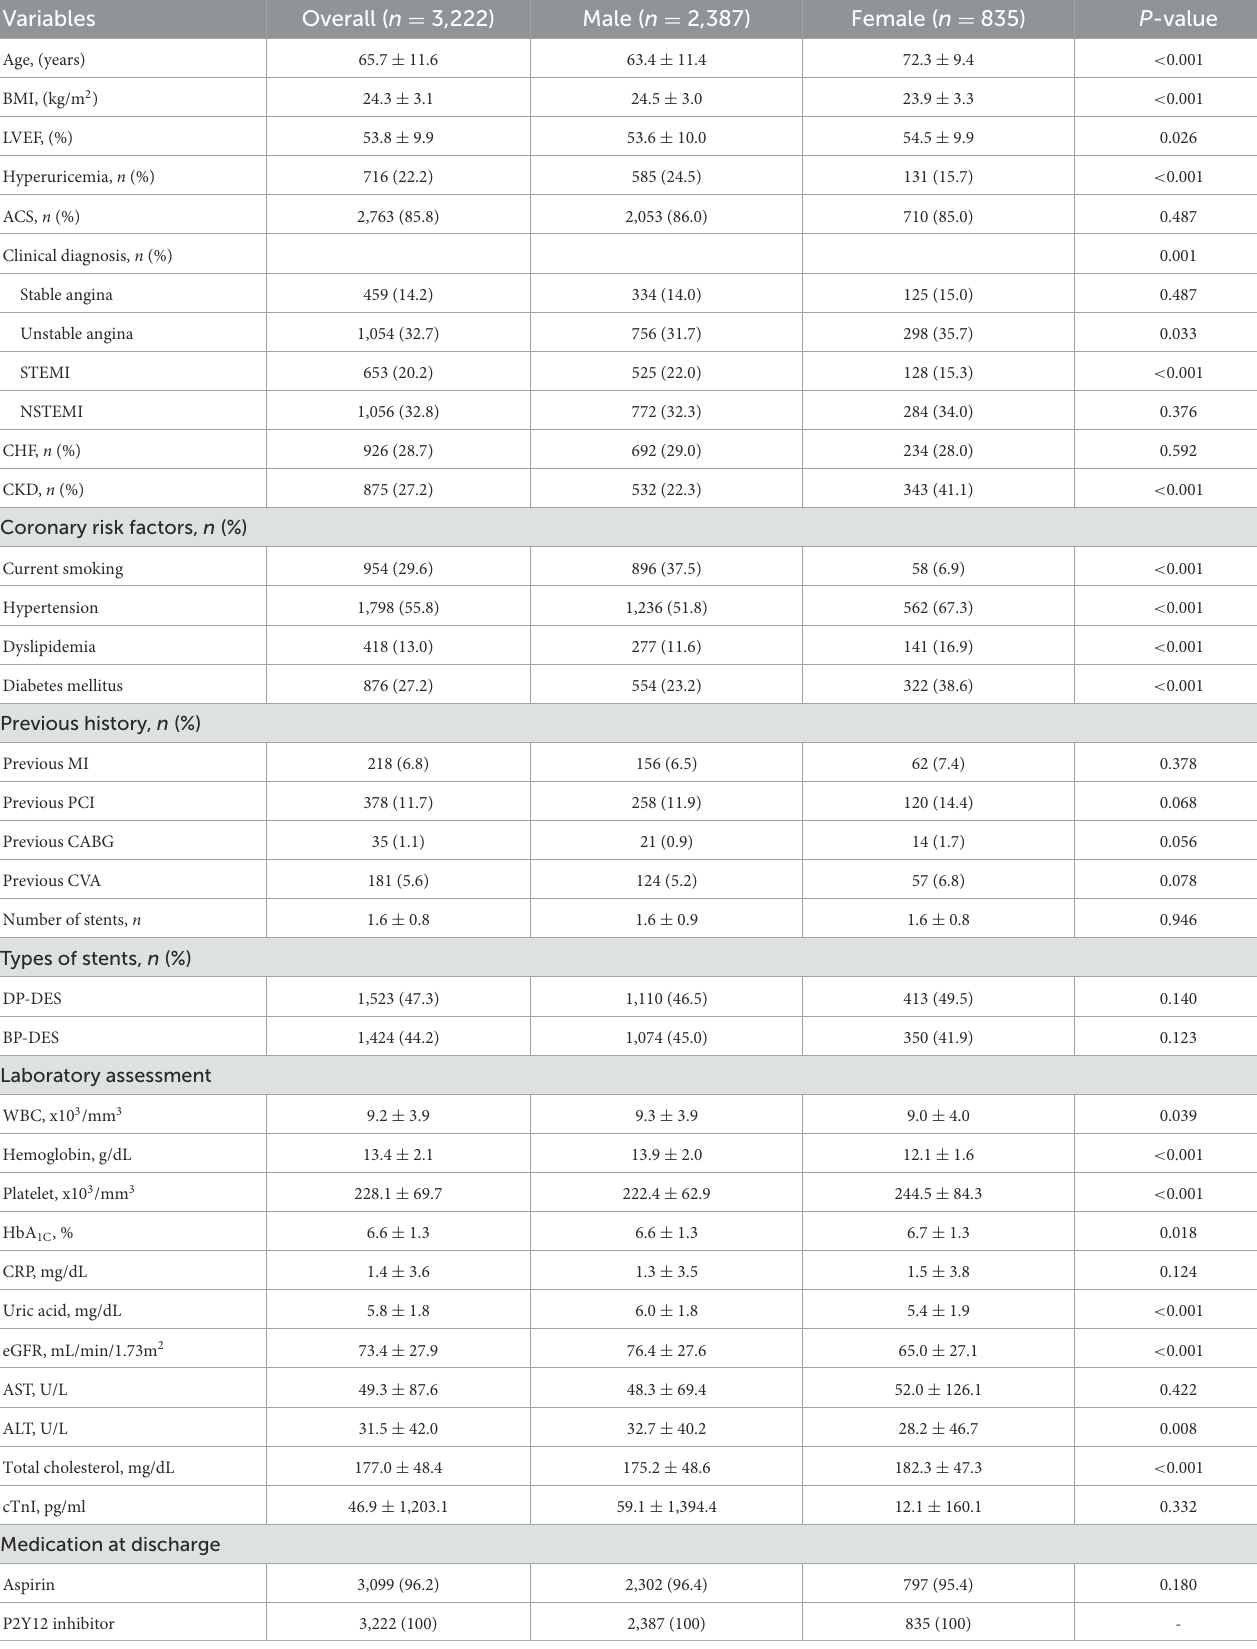
TABLE 1 Baseline characteristics according to